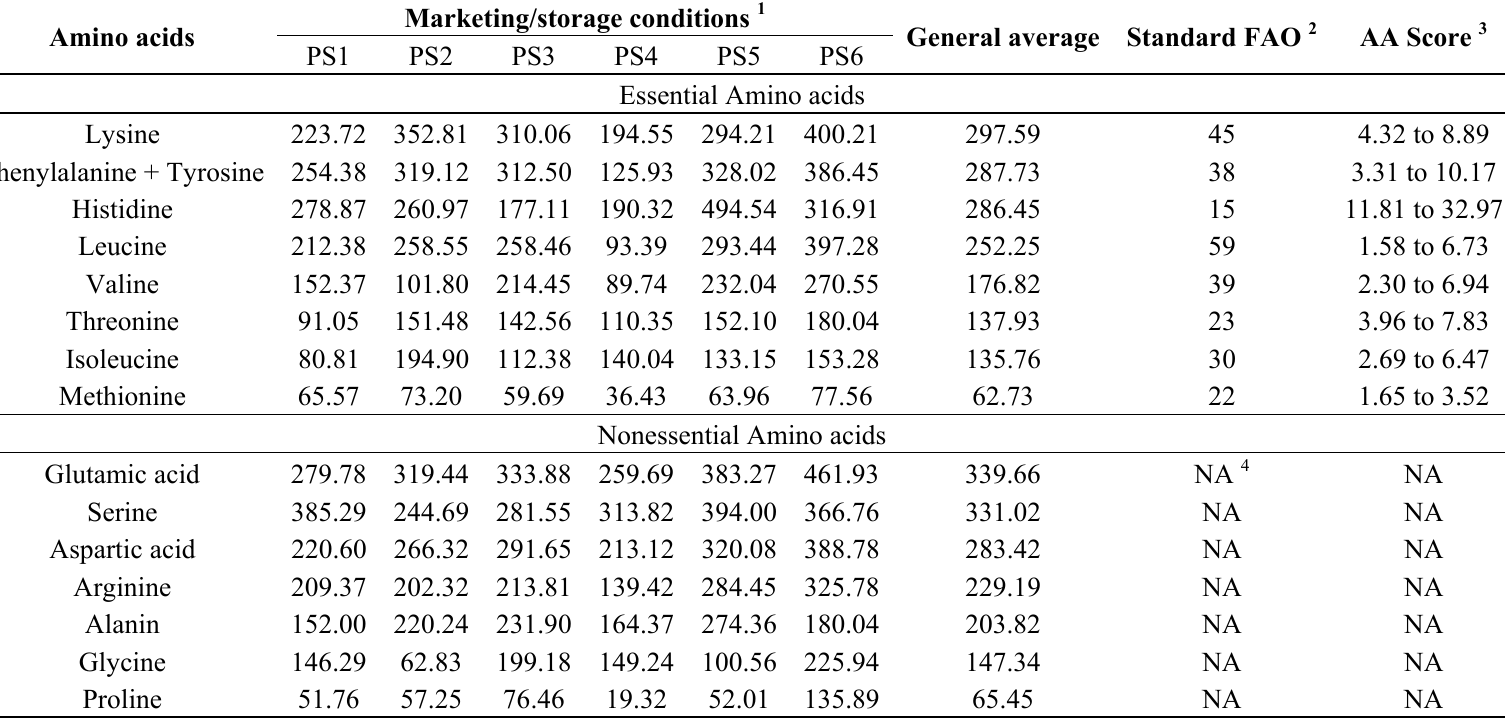
Table 4. Amino acids profile 1 (mg/100 g protein) of goat “sarapatel” under different marketing